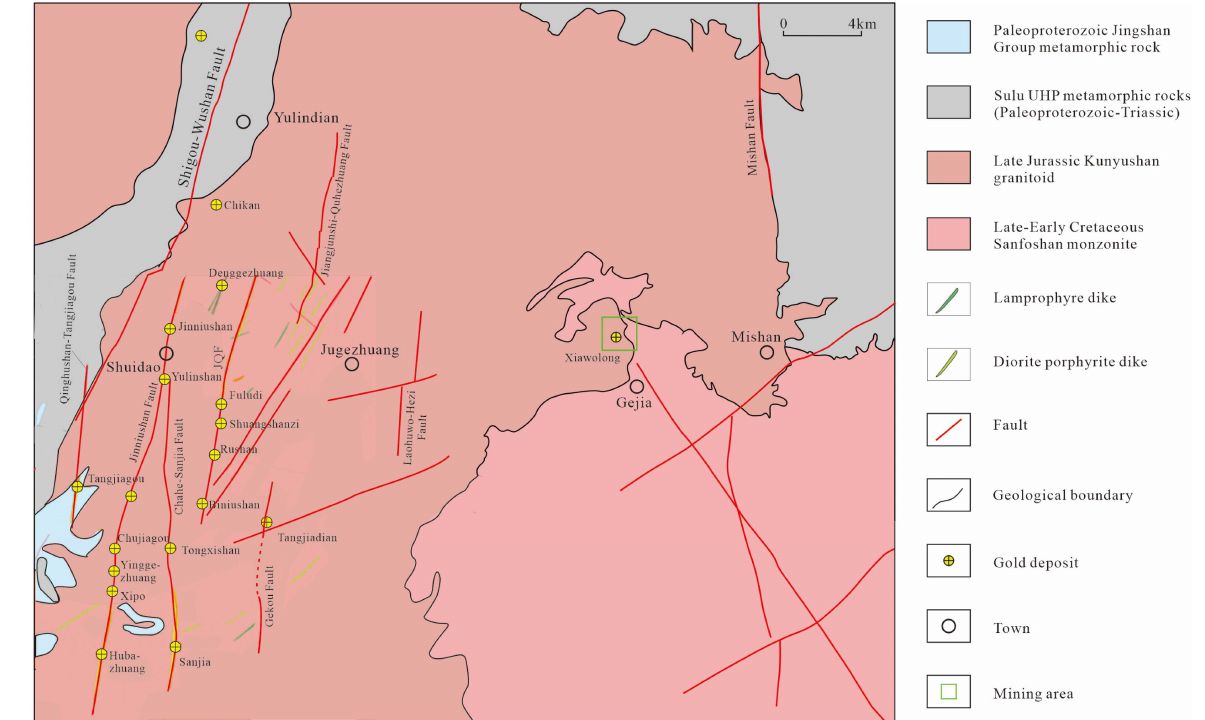
Figure 2. Geological map of the Muping–Rushan gold belt. Adapted with permission from Ref. [46]. 2007, Elsevier.